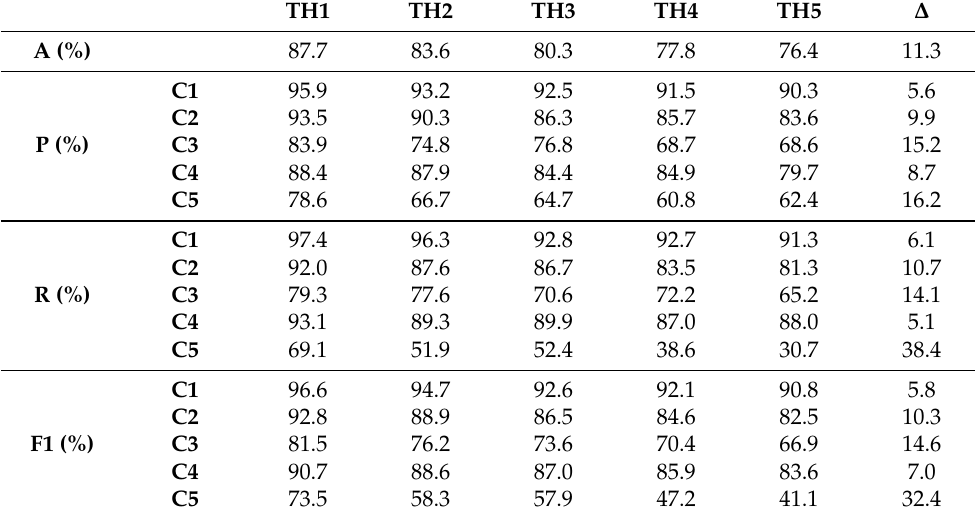
Table 5. Indexes of performance for ANN